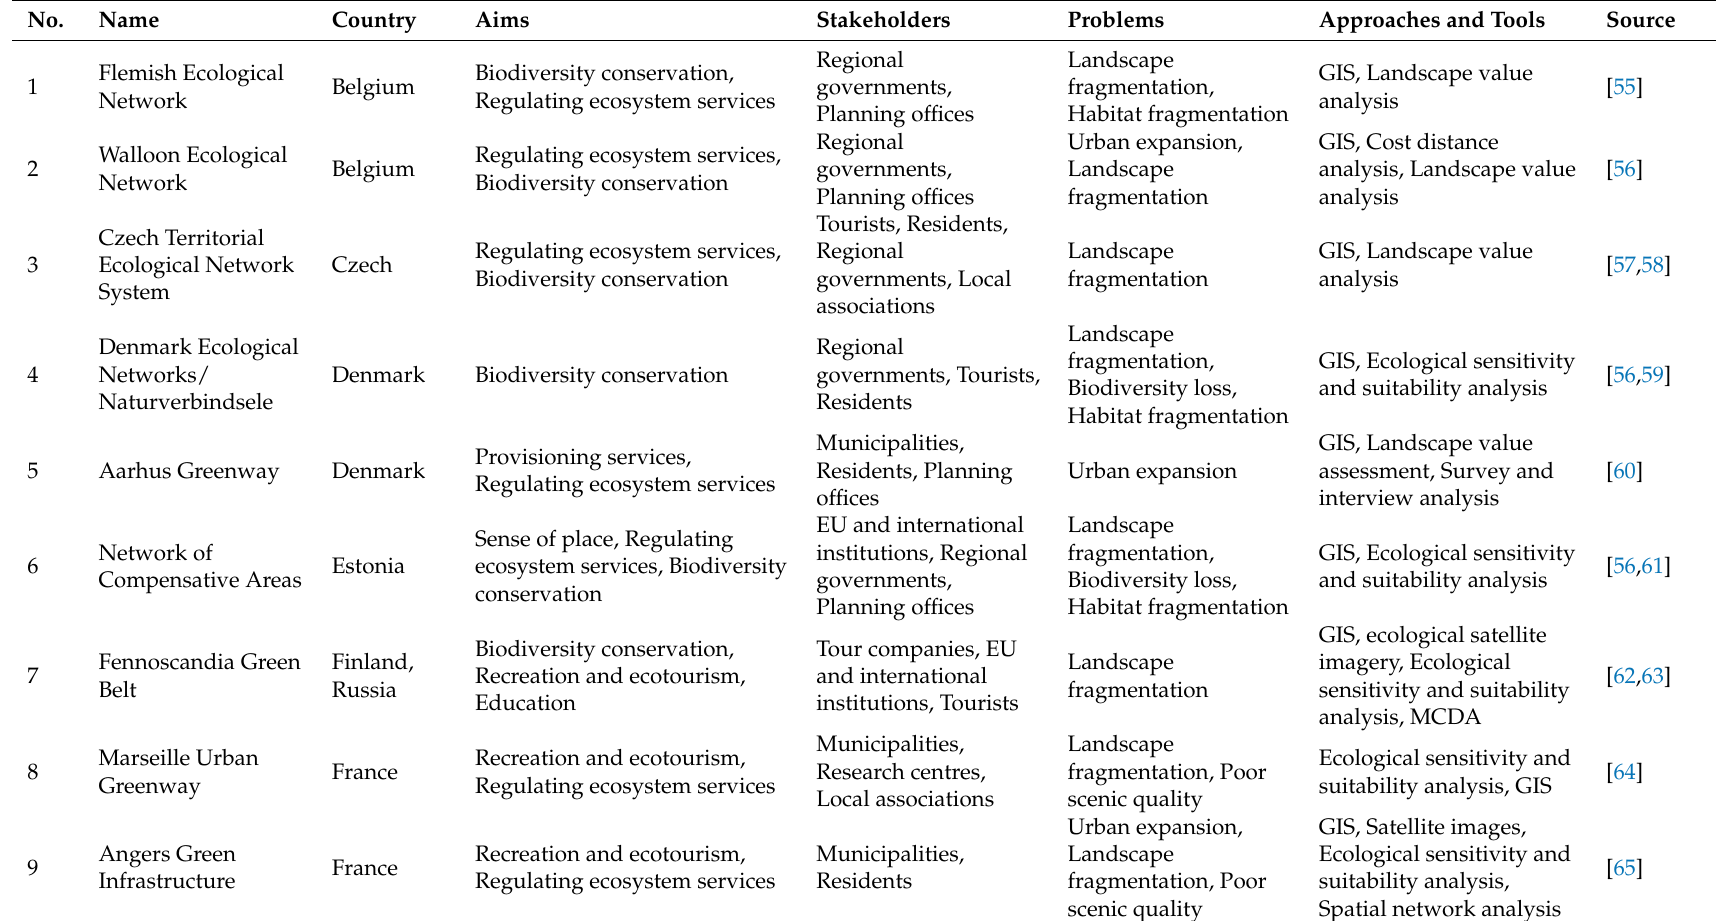
Table A1. Europe’s 92 landscape